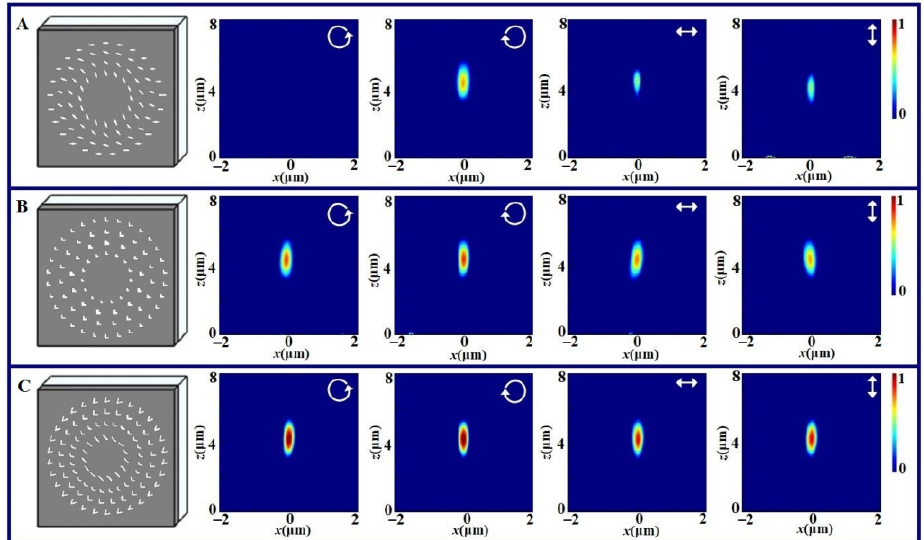
Figure 2. Schematic diagrams of three metalenses and their focusing intensity distributions with LCP, RCP, HLP and VLP light illumination, where ( A ) is for the geometric phase metalens, ( B ) is for the propagation phase metalens and ( C ) is for the resonant phase metalens. The inserted arrows in the intensity distributions denote the incident polarization states.